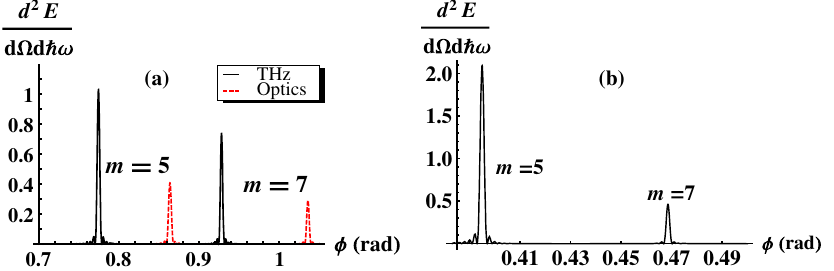
FIG. 8. The distribution of SPR over the conical surface, i.e., at θ ¼ arccos ð β − 1 sin α Þ [see Eqs. (28) and (35)]. (a) THz and optic frequency regions. Parameters are the same as in Fig. 7. (b) X-ray frequency region. Here γ ¼ 4 × 10 4 (electron energy of FACET, SLAC: E ¼ 28 GeV), = ω 2 , α ¼ π = 6 , N ¼ 20 . The minimal value of the horizontal axis is the angle satisfying Eq. (23) or Eq. (47): ε ð ω Þ ¼ 1 − ω 2 p ϕ ≈ 0 . 38